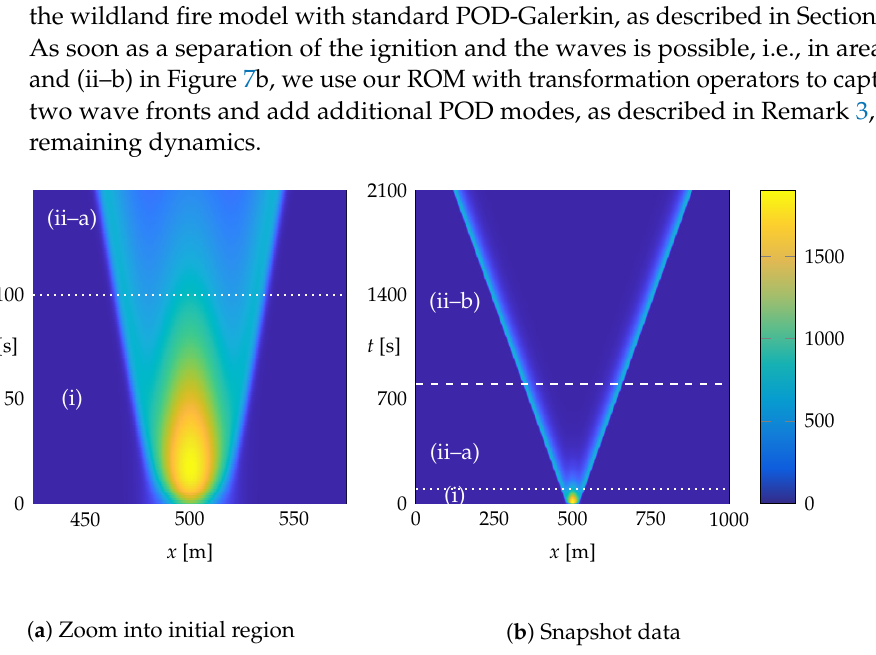
Figure 6. Relative online error of the sPOD-sDEIM ROM with 12 + 2 DOF for β 580 K over the Arrhenius coefficient β ranging from 540K to 580K. }